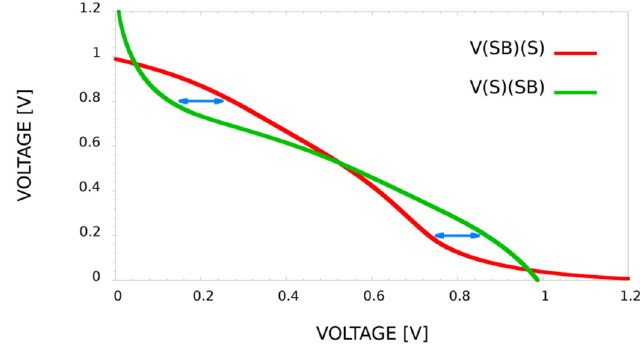
Figure 8. Effect of the R1 defect on SNM.